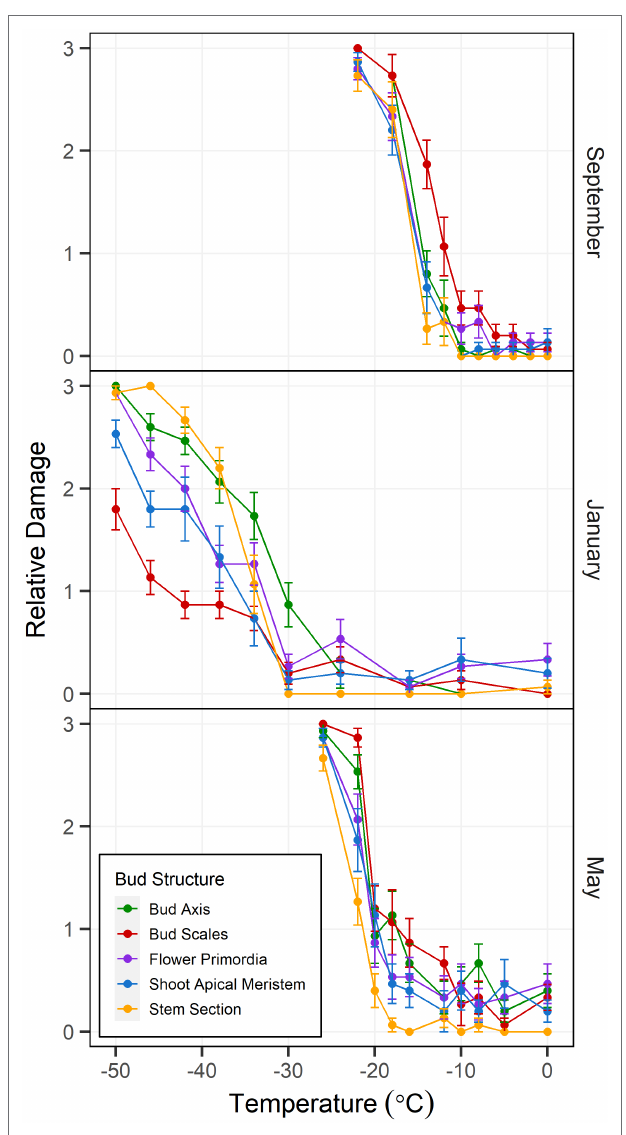
FIGURE 2 | Controlled freezing test-incurred damage according to bud structure in Vaccinium macrocarpon terminal buds. Plant material was sampled in September 2018 and January and May 2019 from a commercial farm in Nekoosa, WI. Damage scoring was performed according to a discrete scale of damage from 0 to 3, where 0 represents no damage and 3 maximum damage. Damage was considered as the area with brown and water-soaked tissues. Each point was obtained from the average damage on each structure ( n = 15). Vertical bars represent SE from the